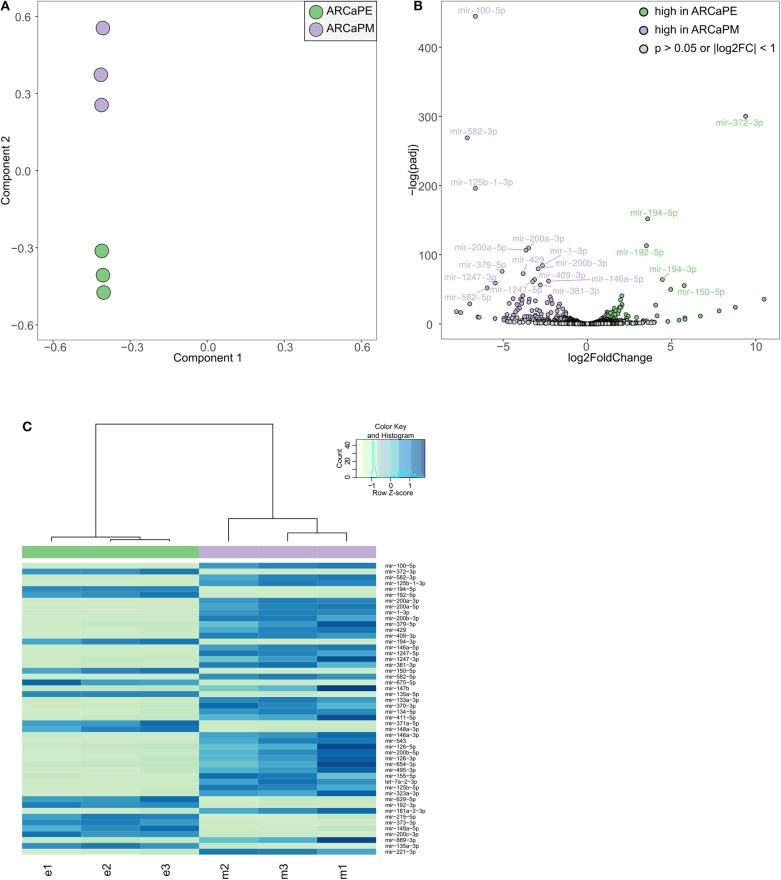
Differential microRNA expression in epithelial and mesenchymal prostate cancer cells. (A) Principal component analysis of small RNA sequencing data from ARCaPE and ARCaPM human prostate cancer cell lines, in triplicates. (B) Volcano plot of significantly differentially expressed microRNAs (p < 0.05, log2 fold change > 1). (C) Heatmap of the top 50 differentially expressed microRNAs (e = ARCaPE, m = ARCaPM).